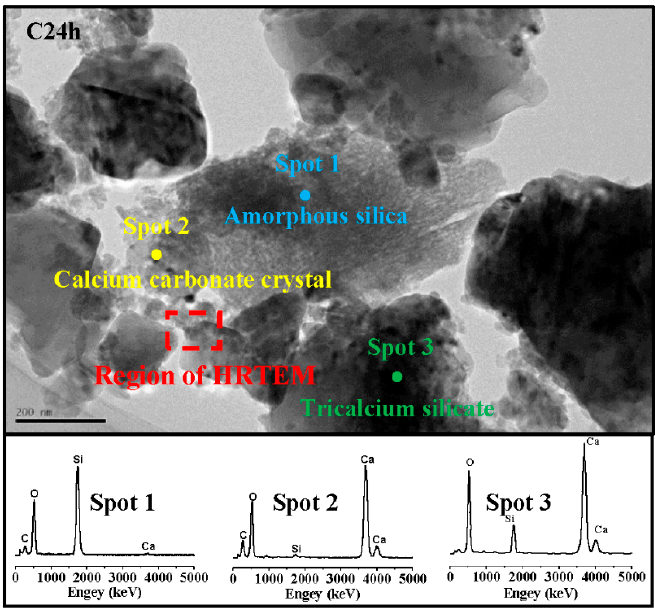
Figure 13. TEM image and EDS mappings of C24h.